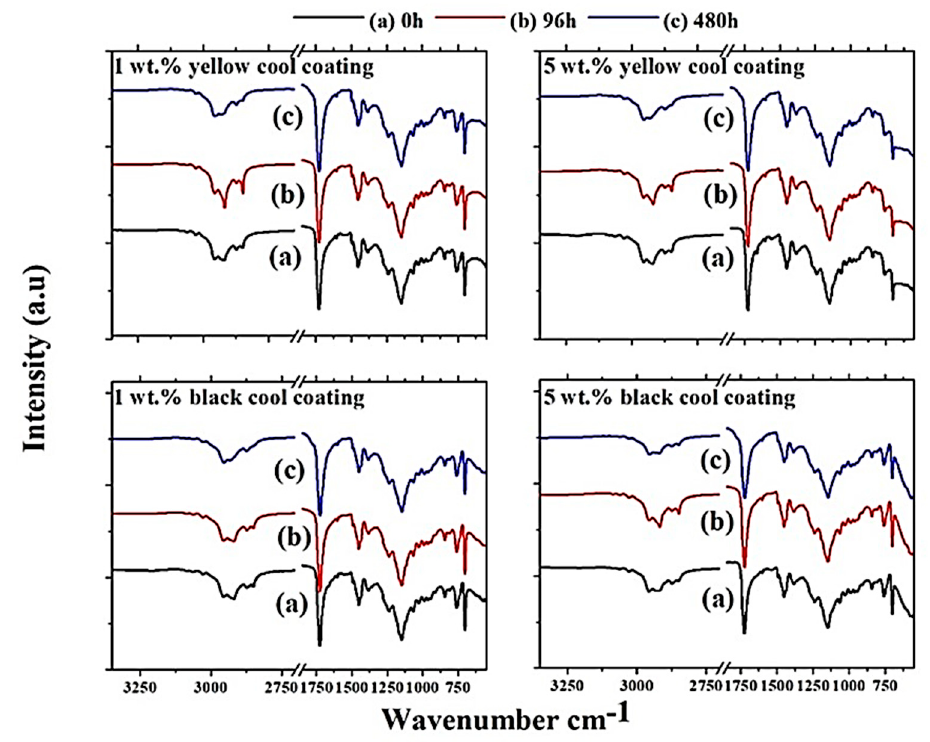
Figure 11. FT-IR spectra for each cool coating containing 1 and 5 wt.% pigments,